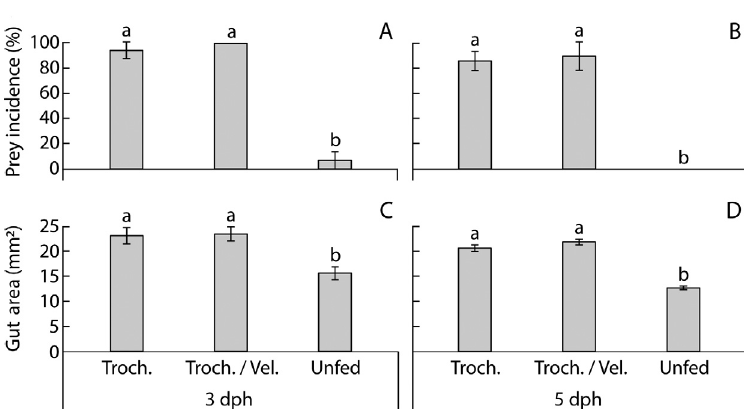
Fig. 5. Effects of diet on (A,B) prey incidence and (C,D) gut area of larval Paracanthurus hepatus at (A,C) 3 and (B,D) 5 days post-hatch (dph). Diets: oyster trochophores only (Troch.), oyster trochophores that developed into veligers during the feeding period (Troch./vel.), and unfed. Prey incidence is the percentage of larvae with material in the digestive tract. Data are means ± SE, n = 3. Bars with the same letters are not significantly different according to